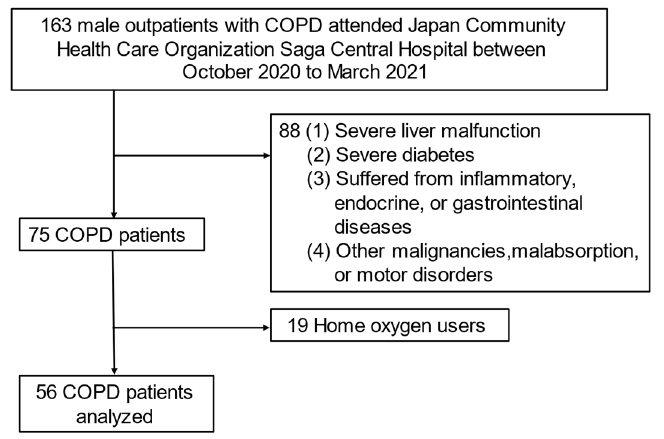
Figure 1. Flowchart of subject recruitment in this study. Abbreviation: COPD—chronic obstructive pulmonary disease.